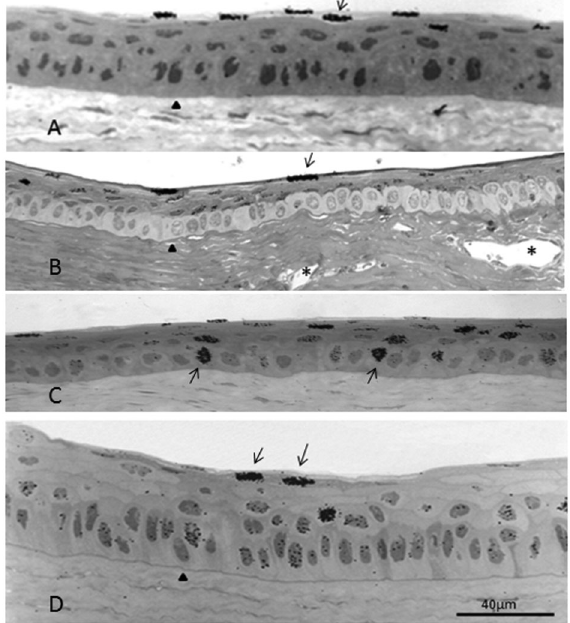
Figure 4. Autoradiography of sections of different regions of the same cornea 28 days after a single intravitreal injection of [ 3 H]- TdR. A , Heavily labeled nuclei in the outermost layer (arrow) and none in the other strata of the central cornea. B , Limbus at a muscle insertion; most of the labeled nuclei are in the suprabasal layers and none in the basal layer. C , Central region of the cornea exhibiting heavily labeled nuclei in the basal stratum. D , Lightly labeled nuclei in the basal and suprabasal strata and 2 heavily labeled nuclei in the outermost layer (arrows) of the central cornea. Arrowheads indicate the basal membranes; asterisks (in Panel B ) are in the lumen of limbal